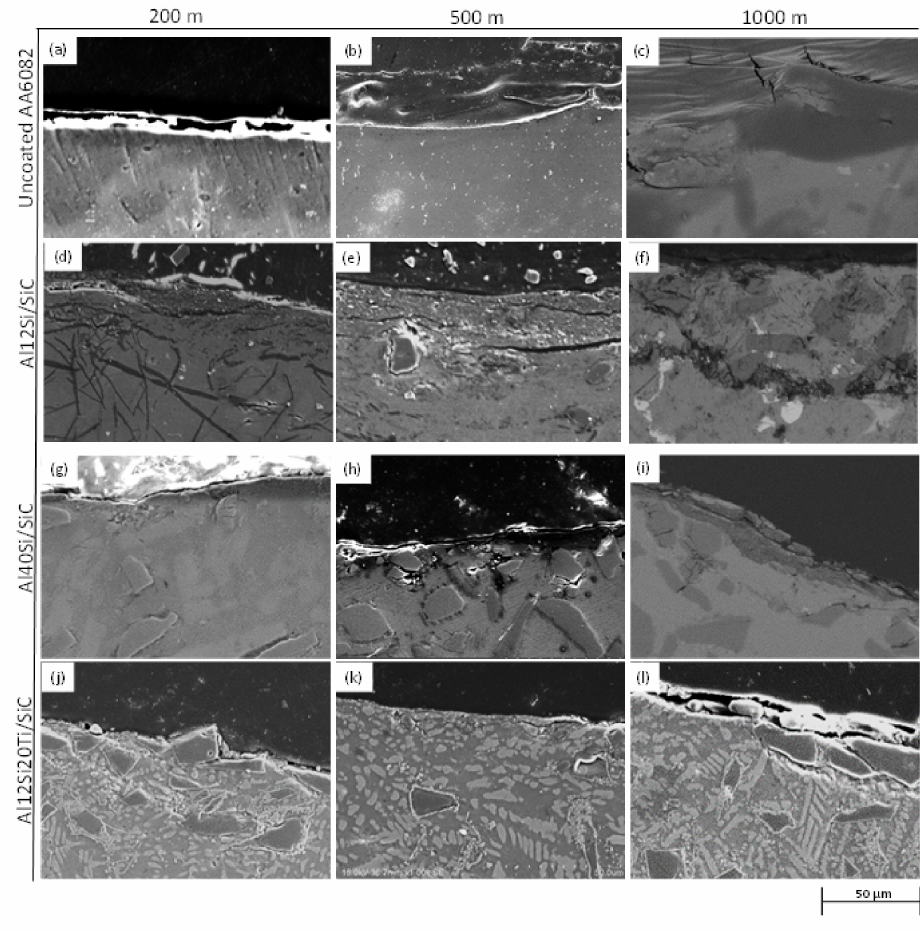
Figure 7. SEM micrographs of the cross-section of the wear surface of the uncoated AA6082 and the different coatings (Al12Si/SiC, Al40Si/SiC, and Al12Si20Ti/SiC) compared to the sliding distances (200 m, 500 m, and 1000 m); ( a ) uncoated AA6082 worn surface (200 m); ( b ) uncoated